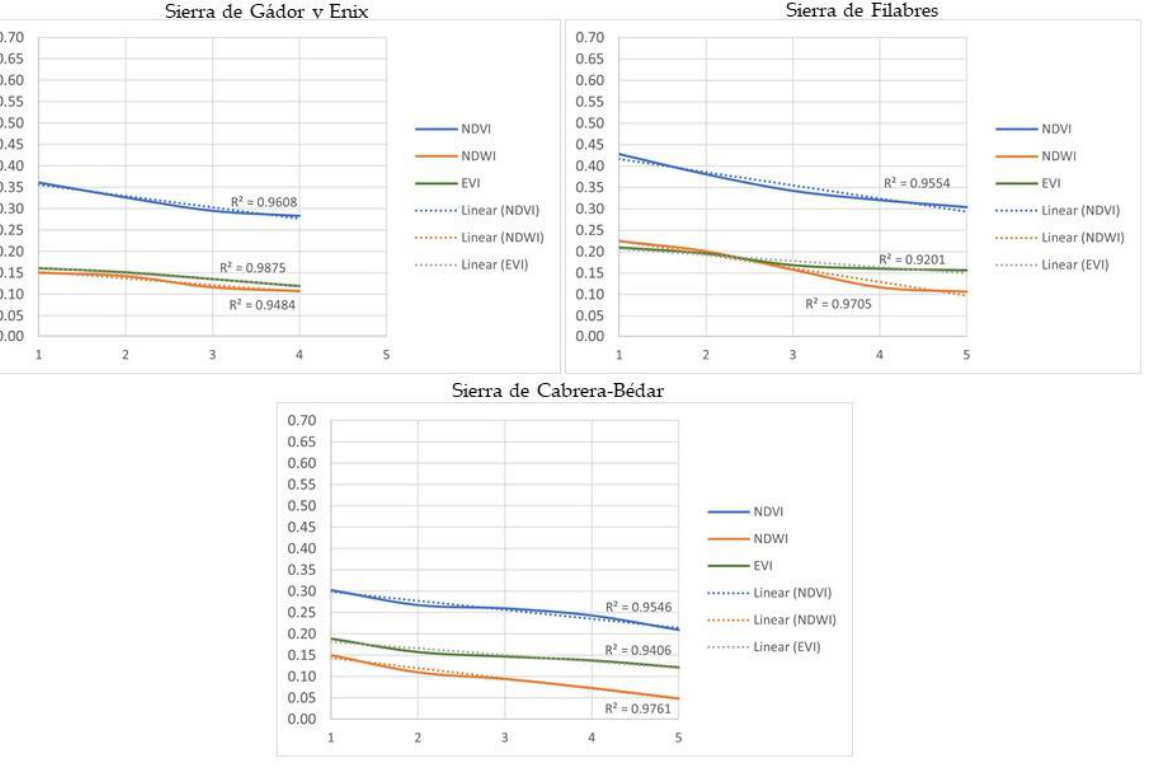
Figure 7. Average values of vegetation indices (NDVI, NDWI, and EVI) in relation to time series (1997 – 2021). Legend. The numeric values of the horizontal axis show the time series: 1, very wet; 2, wet; 3, mean (years around the average); 4, dry and 5, very dry. When series 5 does not appear, very dry, it means that years with that volume of precipitation have not been counted. The numeric values on the vertical axis of the chart show the values that the indices acquire. Own elaboration based on MODIS Land Products: Land Processes DAAC at the U. S. Geological Survey EROS Data Center (EDC). https://lpdaac.usgs.gov/ (accessed on 19 September 2022).